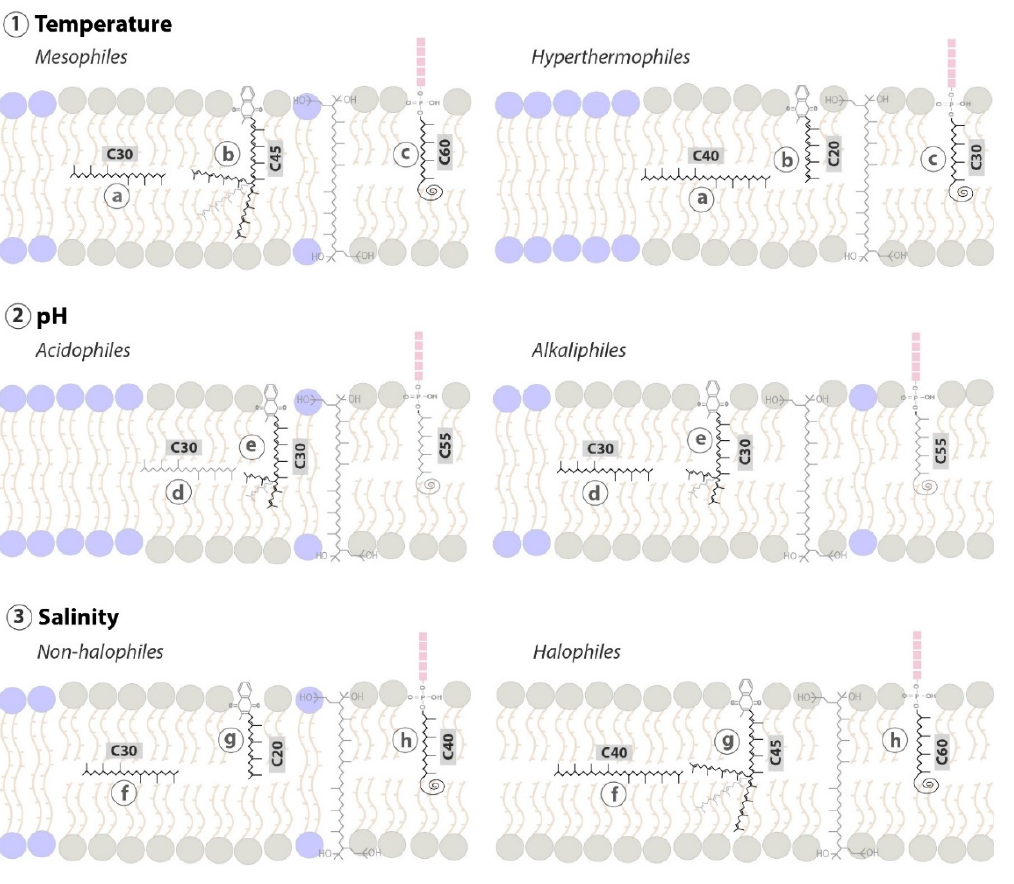
Figure 8. Schematic representation of putative membrane properties modulation by polyterpenes in response to different environmental conditions in Archaea. ( 1 ) Adaptations to temperature: ( a ) longer apolar polyisoprenoids are present in hyperthermophiles. ( b ) and ( c ) mesophiles present menaquinones and polyprenols with higher acyl chains than hyperthermophiles. ( 2 ) Adaptations to pH: ( d ) alkaliphiles possess higher quantities of apolar polyisoprenoids molecules. ( e ) Both, acidophiles and alkaliphiles own menaquinones with medium-length acyl chains. ( 3 ) Adaptations to salinity: ( f ) extreme halophiles present longer apolar polyisoprenoids lipids. ( g ) and ( h ) menaquinones and polyprenols with long acyl chain length are present in extremely halophilic archaea. Grey and blue molecules represent archaeal diether and tetraether lipids, respectively.